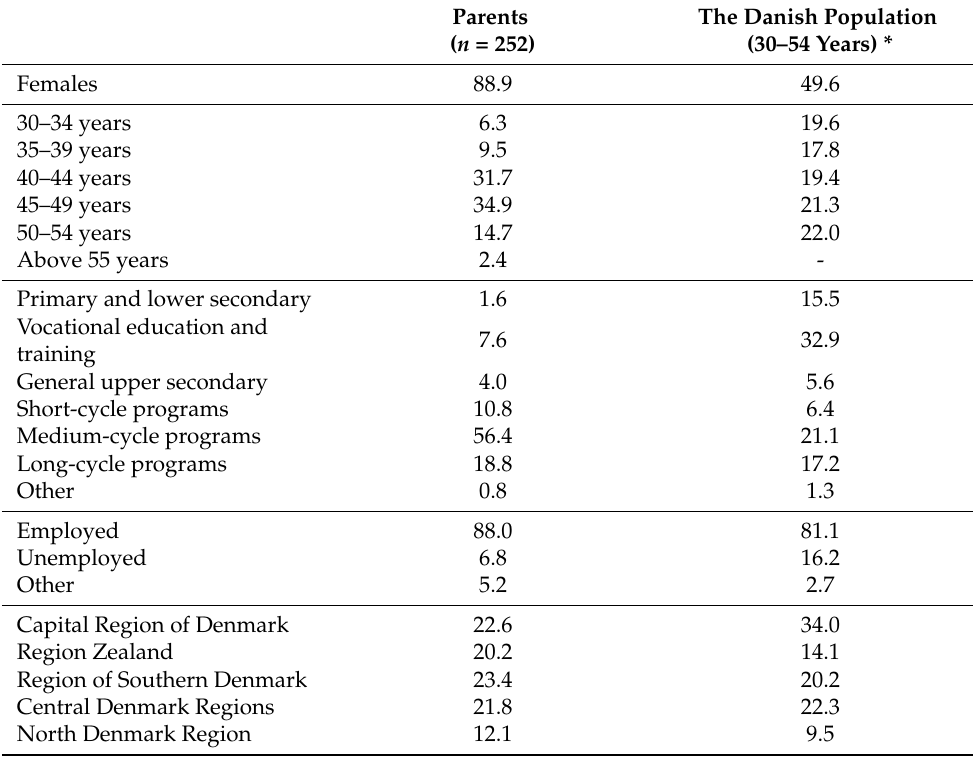
Table A1. Extended description of characteristics of the study population (parents of schoolchildren with type 1 diabetes) and the background population (the Danish population 30–54 years of age). Characteristics are presented in frequencies